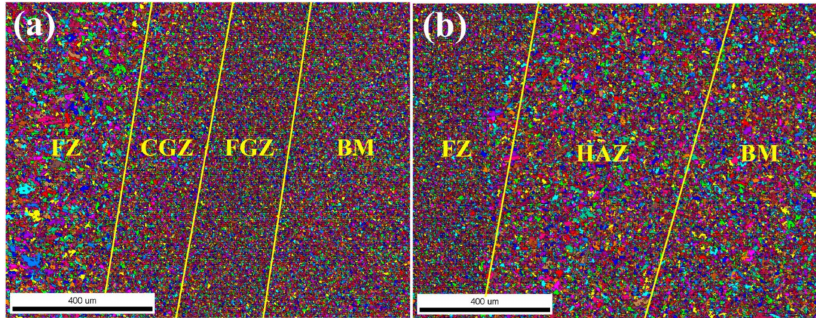
Figure 16. Grain distribution: ( a ) before quenching; ( b ) after quenching.